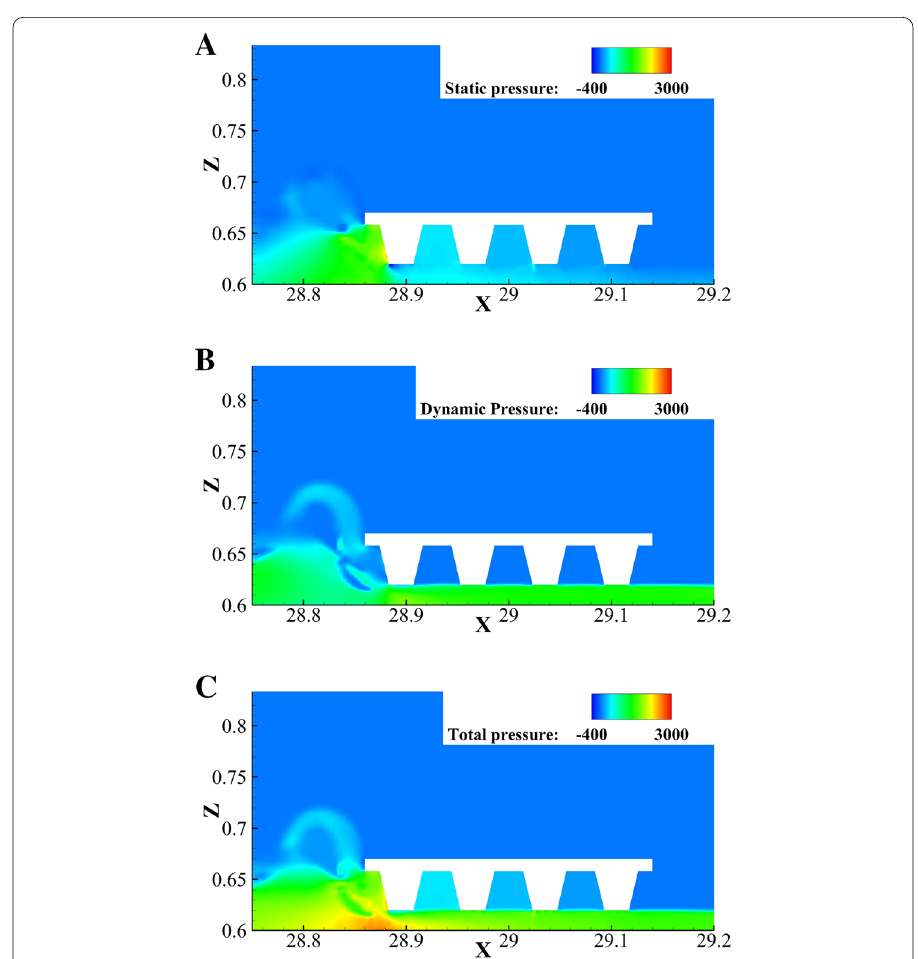
Fig. 18 Static pressure ( a ), dynamic pressure ( b ) and total pressure ( c ) at t pressure: